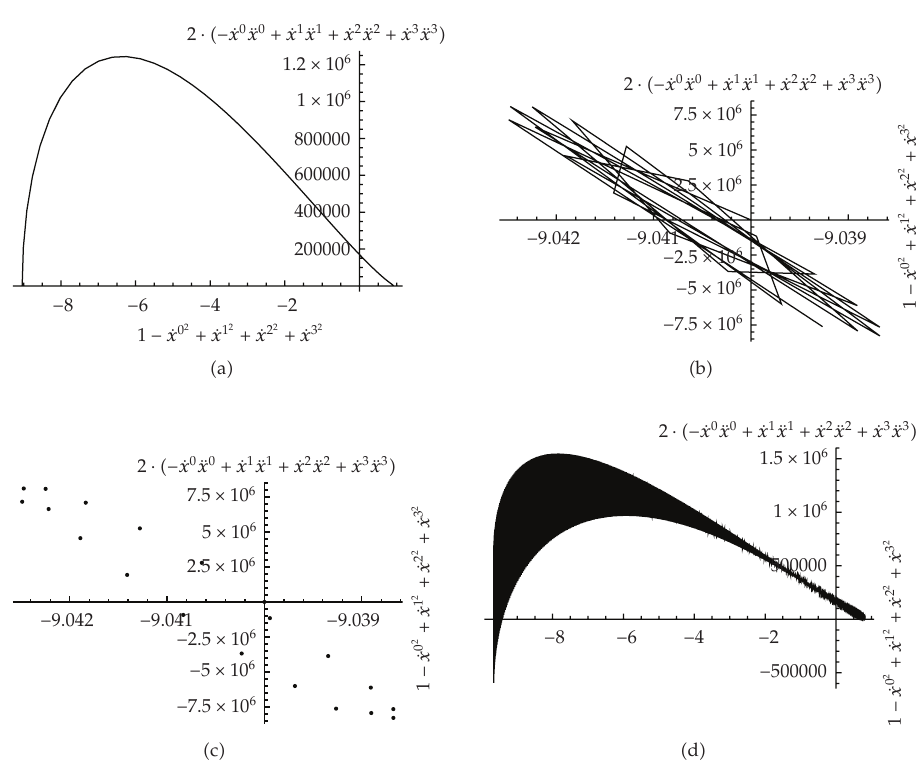
Figure 12: (cid:6) a (cid:7) The orbit without an external field. Initial conditions: ˙ x 0 (cid:3) 3 . 2, ˙ x 1 (cid:3) 0 . 4, ˙ x 2 (cid:3) 0 . 2, ˙ x 3 (cid:3) 0 . 00049, ¨ x 0 (cid:3) 2 . 83, ¨ x 1 (cid:3) 0 . 3, ¨ x 2 (cid:3) 0 . 1, ¨ x 3 (cid:3) − 0 . 0011, M/α (cid:3) 10 5 GeV 2 , and μ (cid:3) 10 − 5 GeV − 1 . (cid:6) b (cid:7) and (cid:6) c (cid:7) The external perturbation added. The edges of the cycling polygonal orbit (cid:6) b (cid:7) form an oval frame, which can be